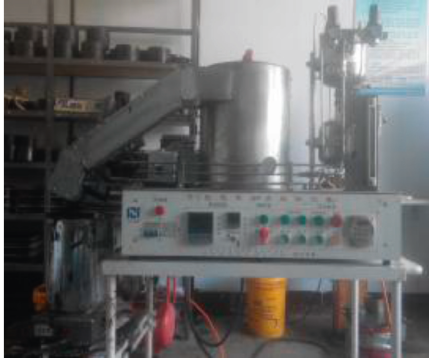
Figure 1: PL-2 foam asphalt production